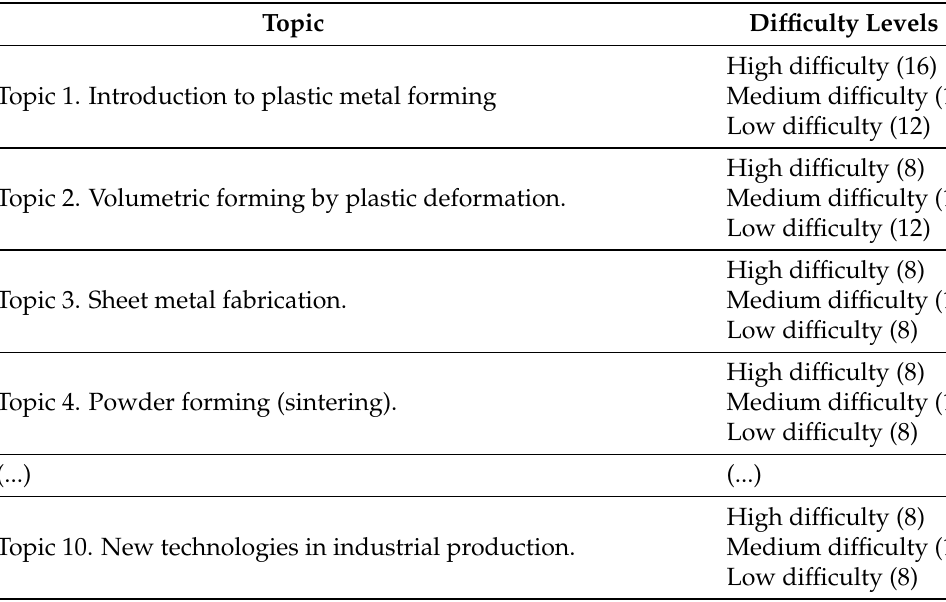
Table 5. Sample question bank according to the level of difficulty.